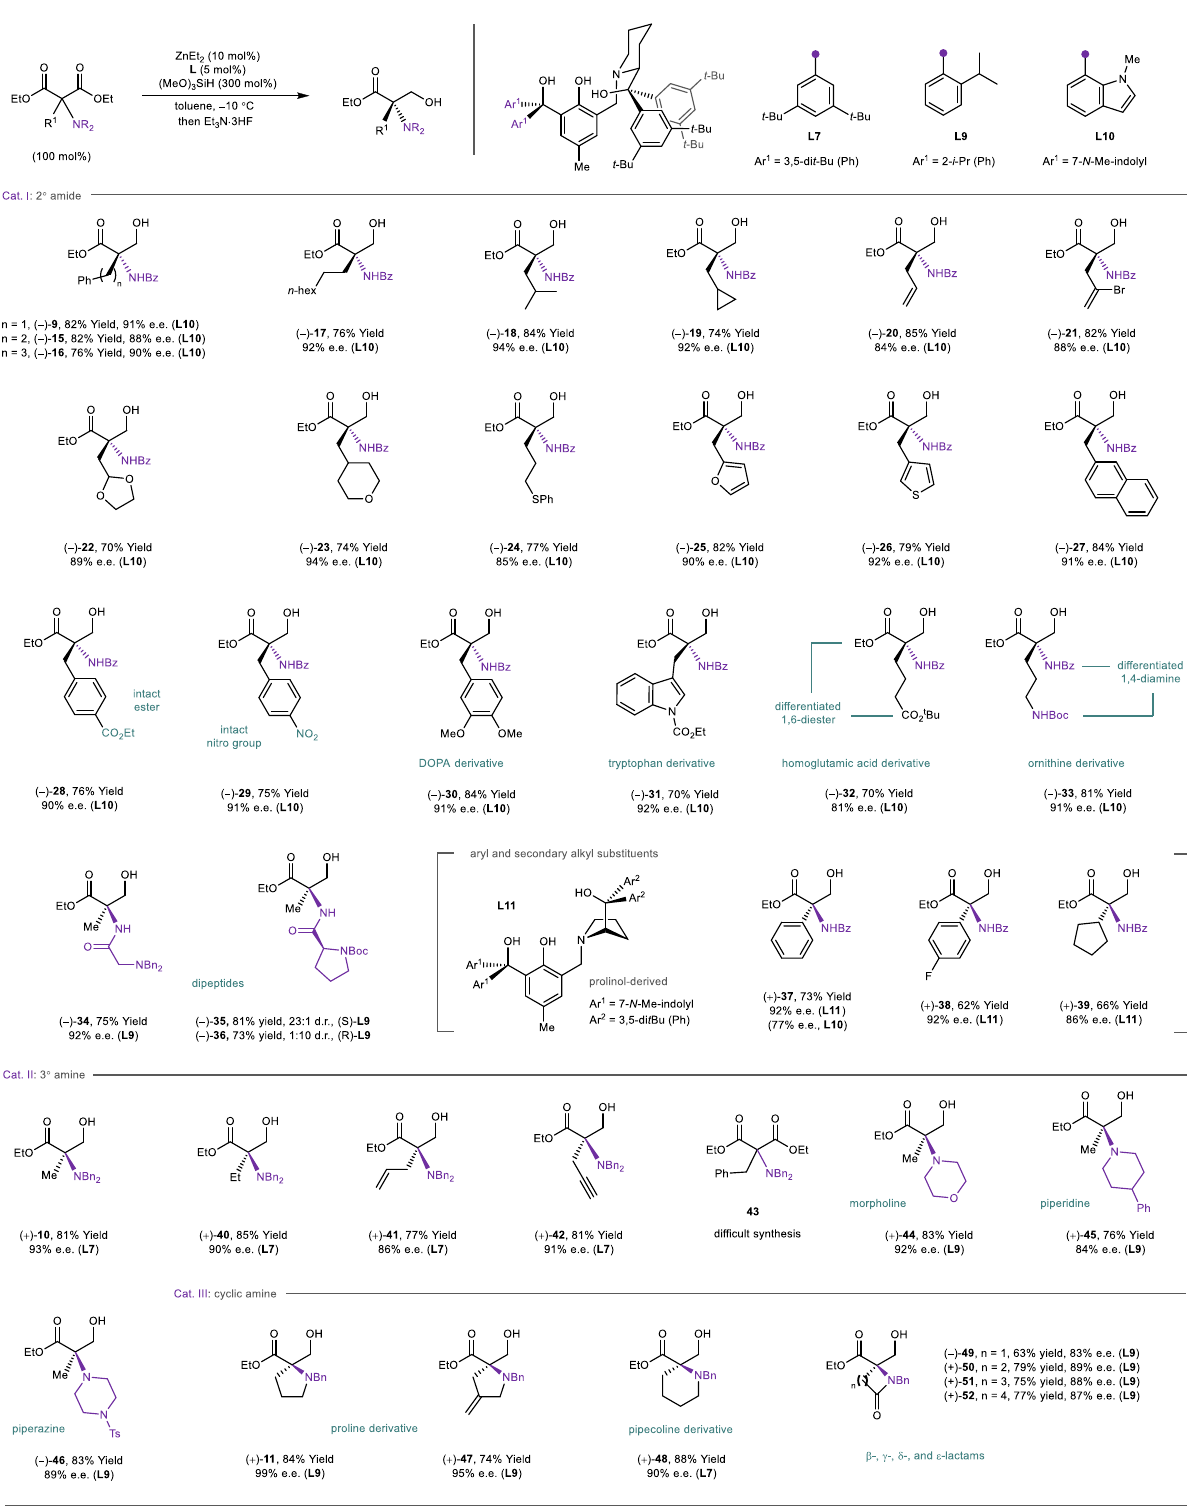
Fig. 3 | Scope of aminomalonic esters. Unless noted otherwise, the desymme- trization was run using aminomalonic ester (0.3mmol), (MeO) 3 SiH (0.9mmol), tetradentate ligand ( L7 , L9 , L10 , or L11 , 5mol%), and ZnEt 2 (10mol%) in toluene at